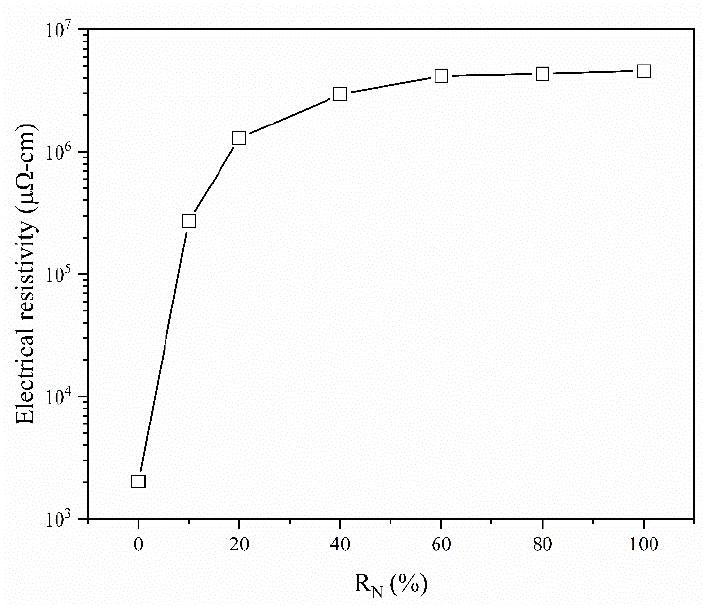
Figure 10. Electrical resistivity of (CrHfNbTaTiVZr)N coatings deposited at various R N .